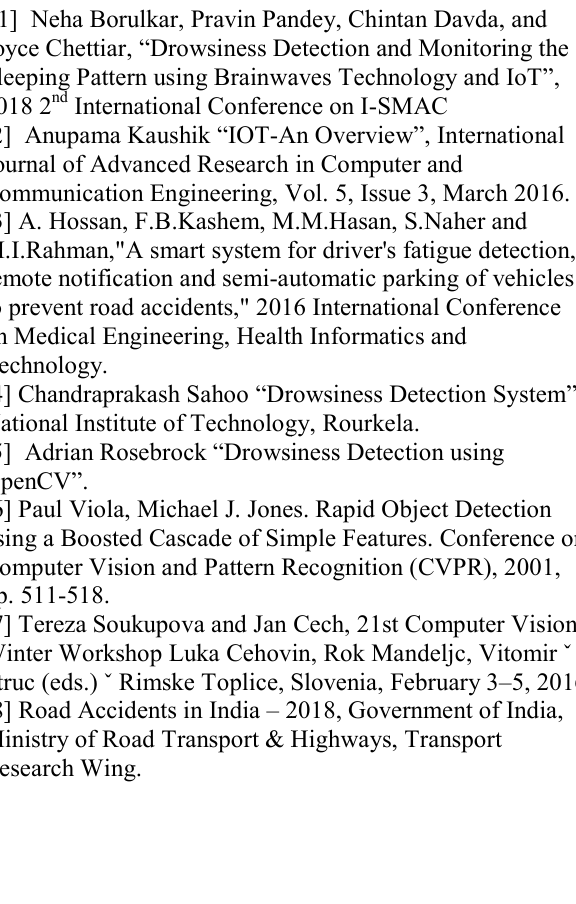
Figure 8: EAR Calculation